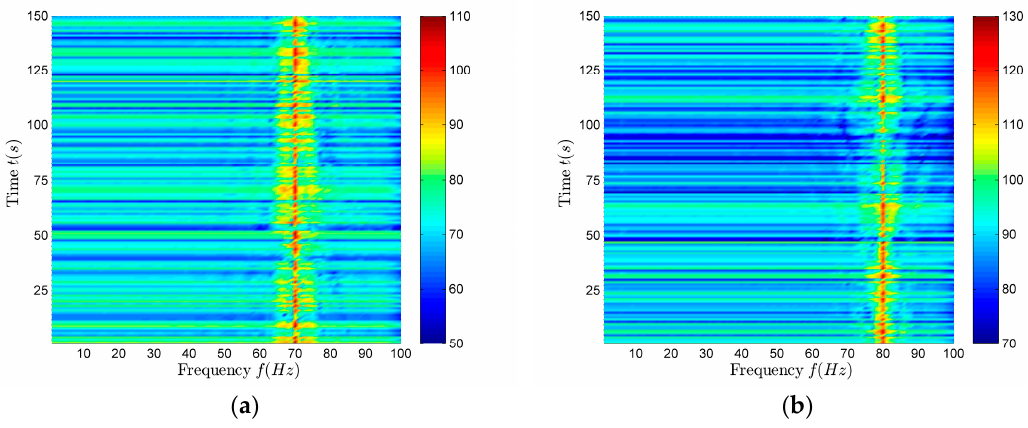
Figure 7. The time-frequency distribution of surface and underwater targets. ( a ) Surface target; ( b ) Underwater target.